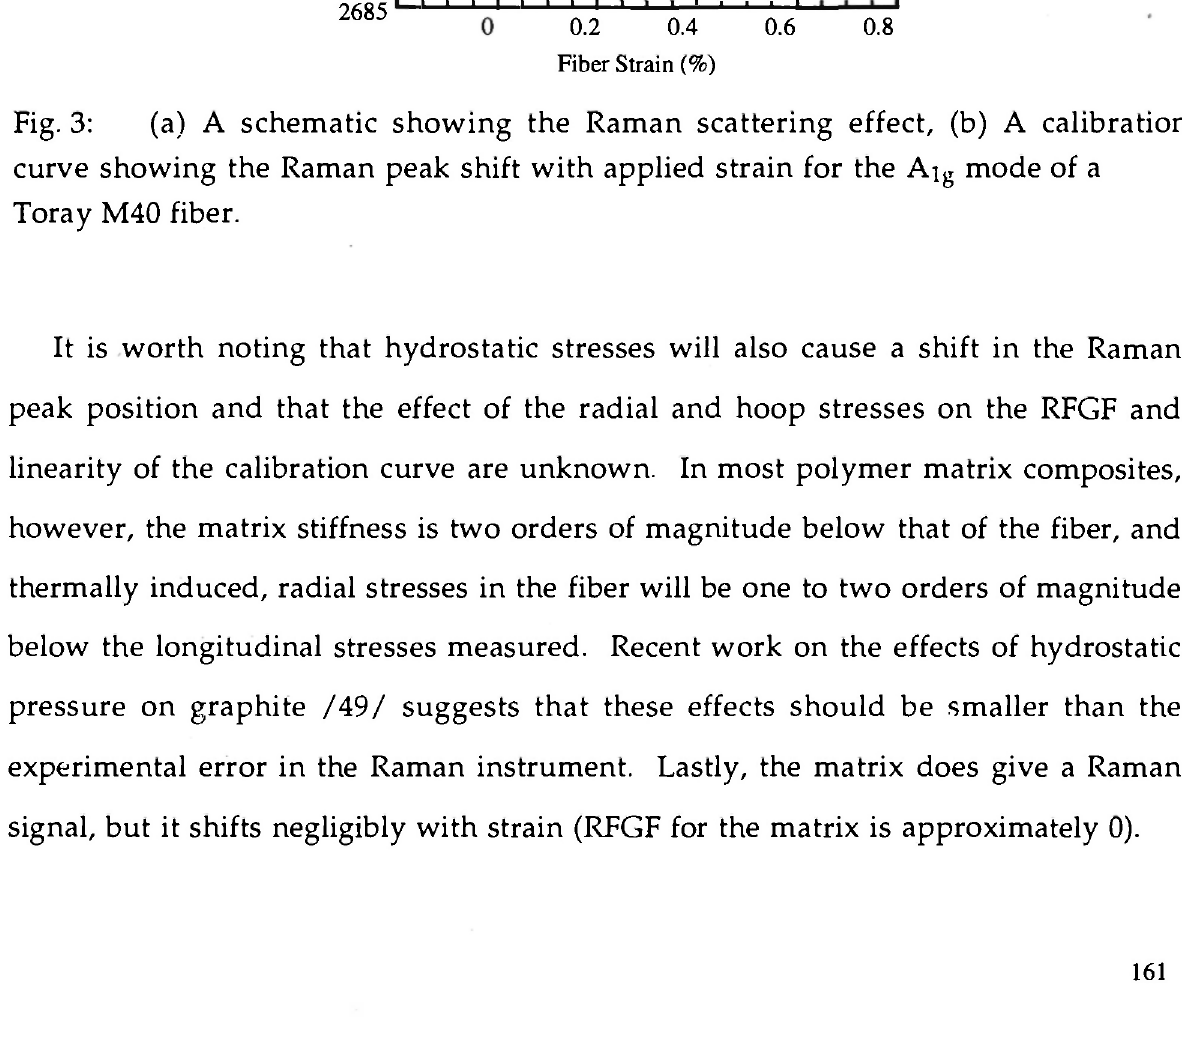
(a) A schematic showing the Raman scattering effect, (b) A calibration curve showing the Raman peak shift with applied strain for the Ai Toray M40